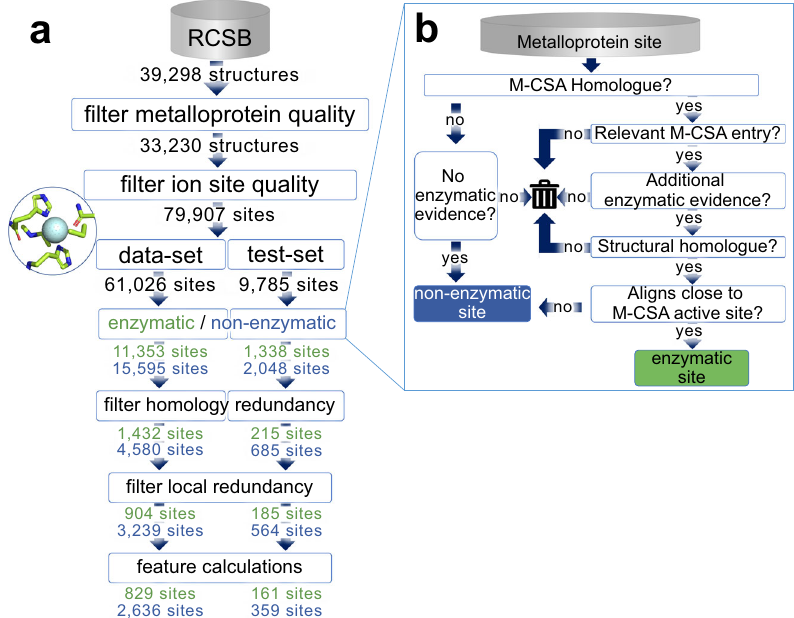
Fig. 1 Work fl ow for dataset generation. a The numbers on each arrow represent the number of entries present at that step; numbers of enzymatic sites are in green, non-enzymatic sites are in blue, and not enzymatically labeled entries are in black. The fi nal numbers are representative of the end of the computational pipeline. b Computational labeling of sites as enzymatic/non-enzymatic via homology expansion of M-CSA (mechanism and catalytic site atlas) (see methods for more